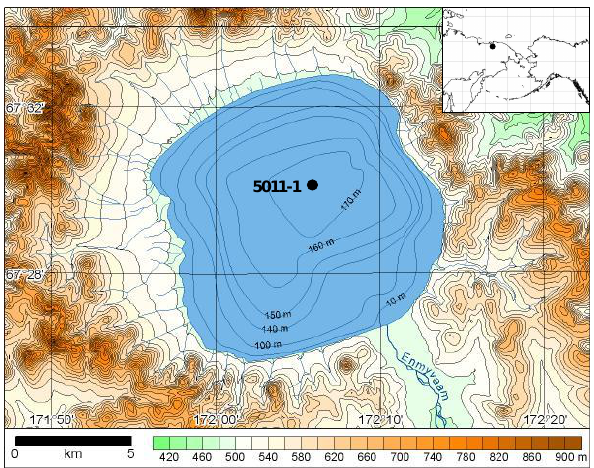
Figure 1. Location of map Lake El’gygytgyn in northeastern Russia (inserted map) with location of the core site.